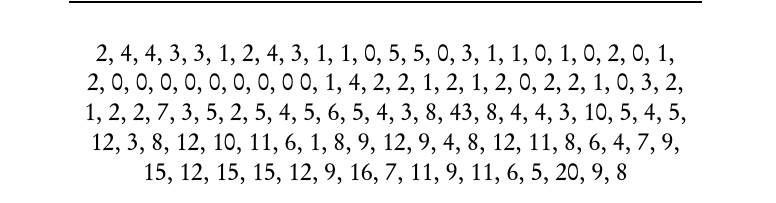
Forest fire in Greece.